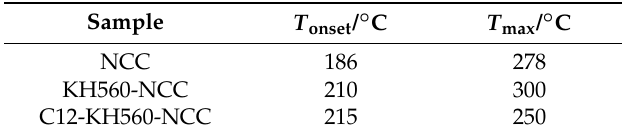
Table 3. Degradation data obtained from TGA for NCC, KH560-NCC and C12-KH560-NCC: T onset and T max corresponds to the beginning of the degradation process and the thermal decomposition temperature associated with the maximum derived signal,